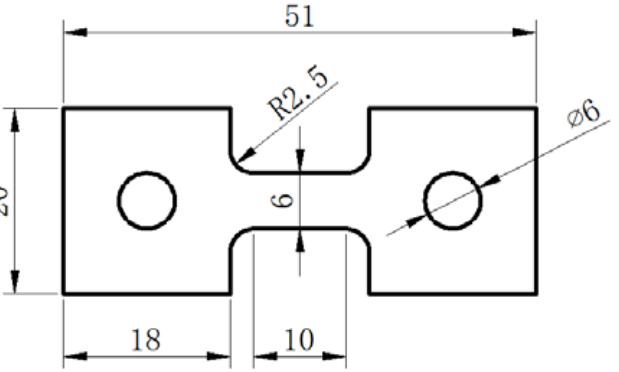
Figure 1. The dimensions of the tensile specimen used for the superplastic test (mm). Similar to the change in strain during SPF/DB, the strain continuously increased from the grip region to the fraction tip position in the superplastic tensile test [30]. The specimens were cut off by wire-electrode cutting for microstructure observation at different locations after superplastic tensile test, as the schematic diagram shown in Figure 2: (i) at the grip position, (ii) at the gauge section near the grip, (iii) at the middle of the gauge section, and (iv) near the tip of the fracture. The specimen surfaces were grounded with a series of SiC abrasive sheets, polished electrochemically with a solution of 5% HCLO 4 + 95% CH 3 COOH at a voltage of 65 V at room temperature, and etched with Kroll’s reagent (2 mL HF, 8 mL HNO 3 , and 82 mL H 2 O). The microstructure and phase composition of the specimen were studied by the scanning electron microscope (SEM, JEOL JEM-7900, Beijing, China) coupled with the OXFORD Chanel 5 system to perform the electron backscatter diffraction (EBSD) analysis. The pole figures (PFs) and inverse pole figures (IPFs) were calculated from the EBSD data with a step size of 0.05 µ m. In this study, when the misorientation angle is less than 15 ◦ , the boundaries were definite as low angle boundaries (LAGBs), while the misorientation angle of high angle boundaries (HAGBs) was higher than 15 ◦ . To study the morphology of phases and dislocations in the grain of SP700 alloy during superplastic deformation, thin foil samples were prepared by a focused ion beam (FIB) instrument and were evaluated by transmission electron micrograph (TEM) on Tecnai G2 F20. TEM coupled with energy dispersive spectrometry (EDS) was chosen to analyze the distribution of alloy